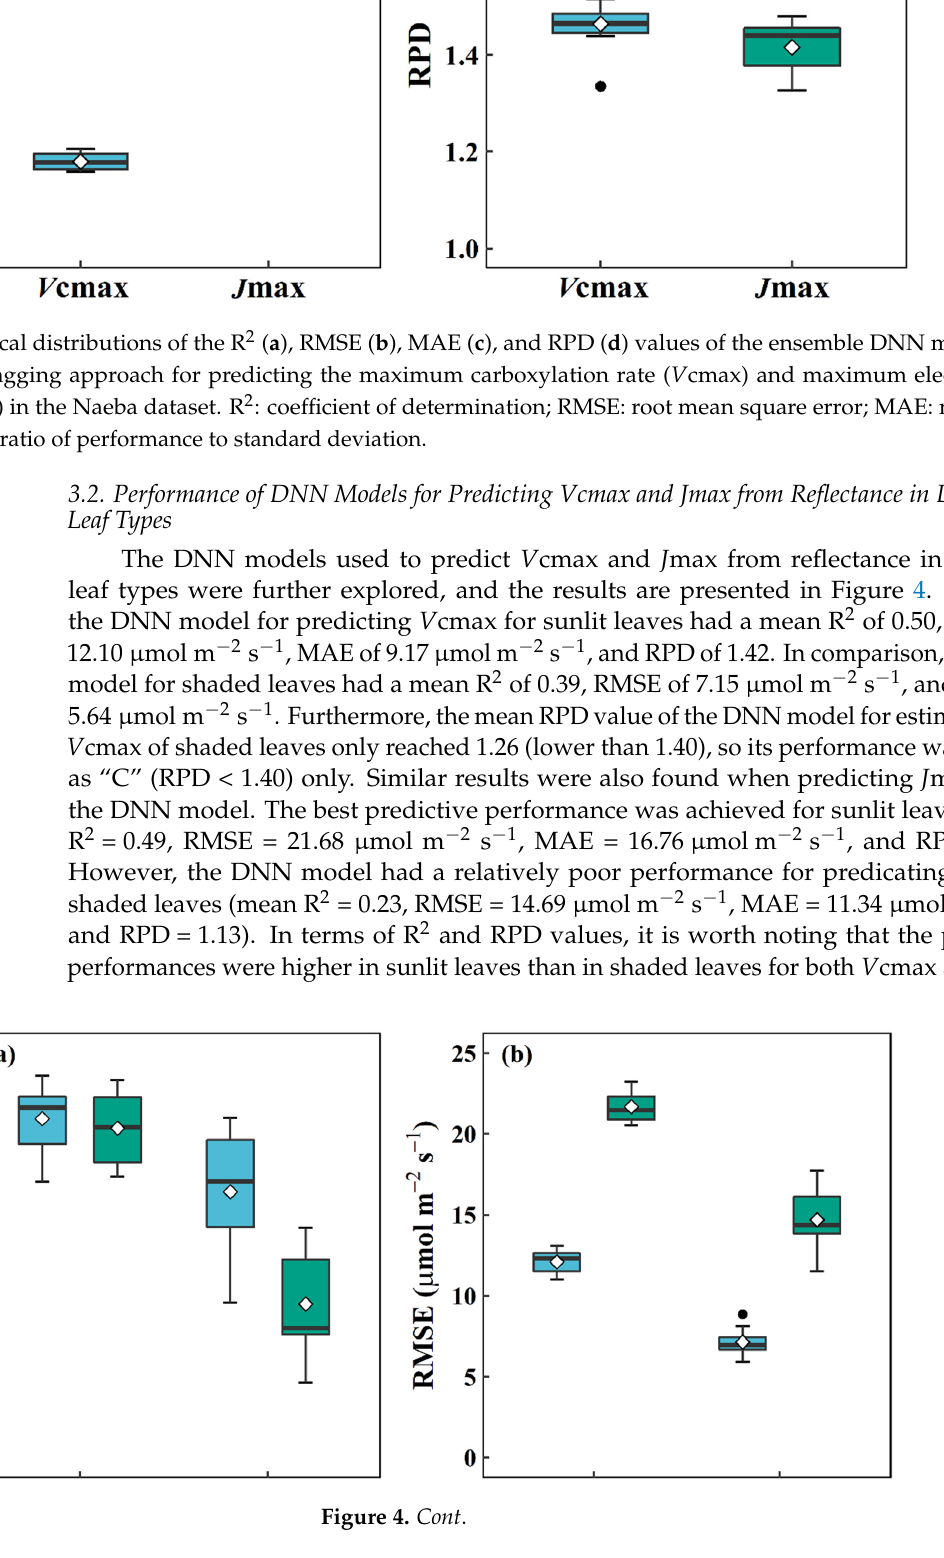
Figure 4. The statistical distributions of R 2 ( a ), RMSE ( b ), MAE ( c ), and RPD ( d ) for predicting the maximum carboxylation rate ( V cmax) and maximum electron transport ( J max) in sunlit and shaded leaves using the ensemble DNN model. R 2 : coefficient of determination; RMSE: root mean square error; MAE: mean absolute error; RPD: ratio of performance to standard deviation. 3.3. Performance of DNN Models for Predicting Vcmax and Jmax from Reflectance during Different Growing Periods Distinctive DNN models were trained to predict V cmax and J max in different grow- ing periods, namely, leaf flushing, maturity, and senescence. Their respective perfor- mances are listed in Table 1. Specifically, the estimations of V cmax (based on the mean R 2 and RPD values) during the flushing period (mean R 2 = 0.70, RPD = 1.85) were considera- bly higher than those in the mature (mean R 2 = 0.48, RPD = 1.41) and senescence (mean R 2 = 0.52, RPD = 1.46) periods, in terms of R 2 and RPD. Likewise, the estimation of J max was best during the flushing period (mean R 2 = 0.78, RMSE = 16.60 μ mol m − 2 s − 1 , MAE = 12.06 μ mol m − 2 s − 1 , RPD = 2.15), followed by the leaf senescence period (mean R 2 = 0.55, RMSE = 18.84 μ mol m − 2 s − 1 , MAE = 15.04 μ mol m − 2 s − 1 , RPD = 1.47). The poorest model performance was found during the mature leaf period, with a mean R 2 of 0.50, RMSE of 19.68 μ mol m − 2 s − 1 , MAE of 15.18 μ mol m − 2 s − 1 , and RPD of 1.43.